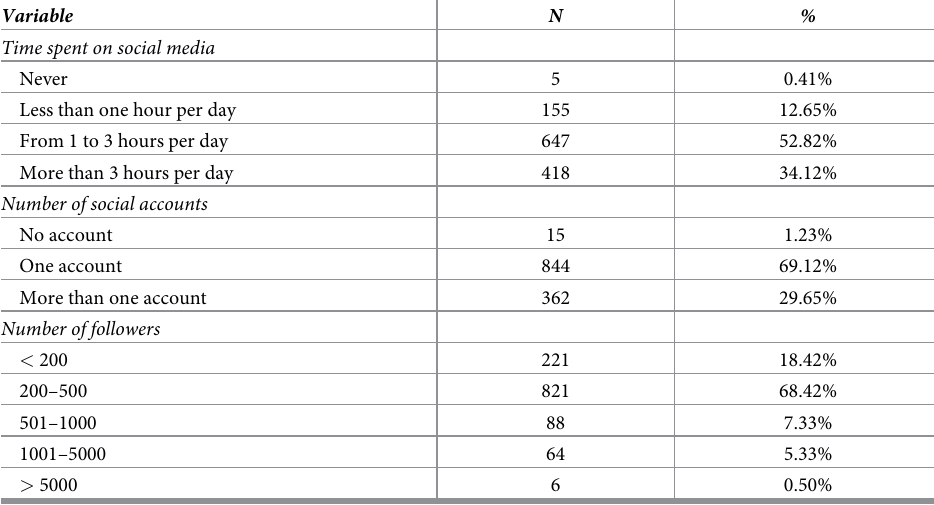
Table 3. Use of social